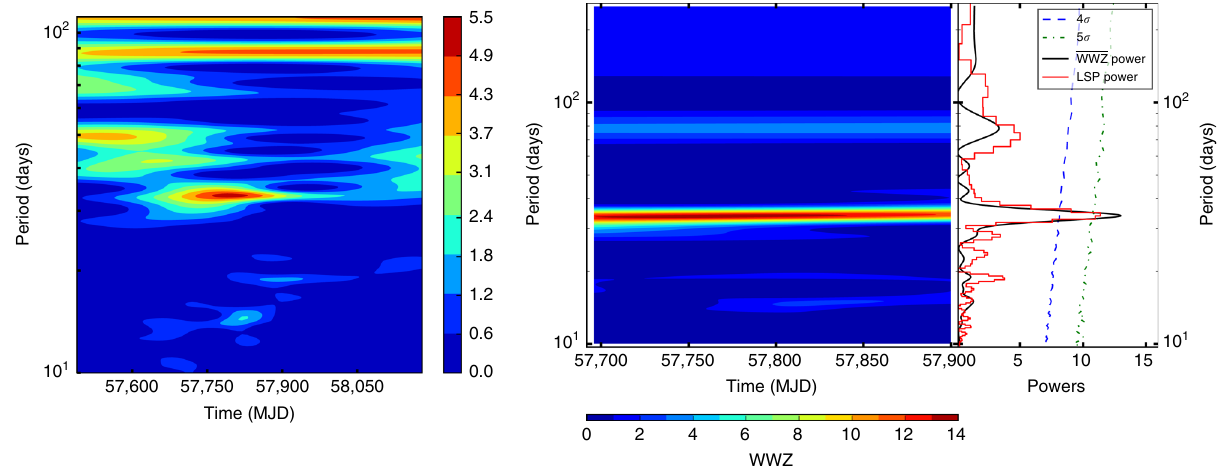
Fig. 2 Detection of the quasi-periodic oscillation signal. In the left panel, the WWZ power for the whole light curve in Fig. 1 is shown. A periodicity around ~34 days is detected in the time period of MJD 57693 – 57903, as indicated in Fig. 1. In the right panel, we show the WWZ power and LSP power obtained for the light curve in the time period of the periodic modulation. The black and red curves are the time-averaged WWZ power and LSP power, respectively. The blue dashed and green dash-dotted curves are 4 σ and 5 σ signi fi cance curves, respectively, obtained from the light curve simulation. The simulation indicates that the signal has a signi fi cance of 5.2 σ (or 4.6 σ considering a trial number of